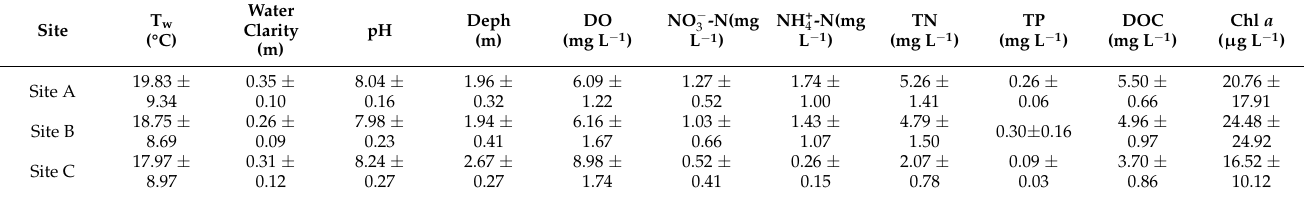
Table 1. Basic environmental variables of different observation sites during the observation period (Site A (2012–2013), Site B, and Site C (2012–2017)). Data were shown as mean ± one standard